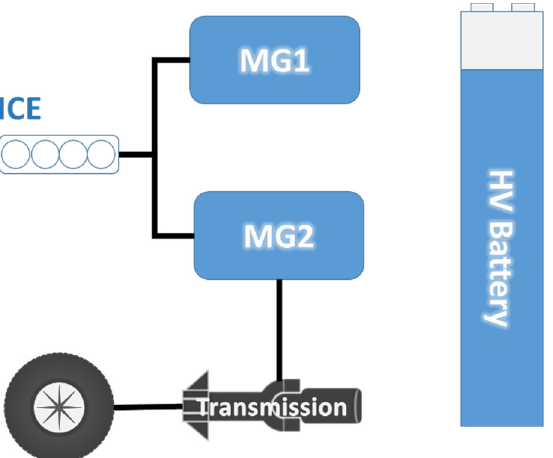
Figure 6. Simplified mechanical diagram of the Toyota Yaris hybrid drive system.